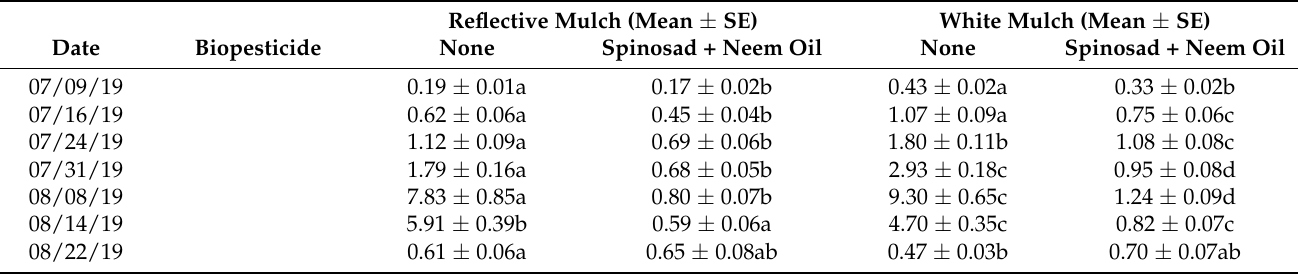
Table 2. Significant effects of highest order interactions on mean ( ± SE) adult thrips densities per leaf. Significant effects include the interactions of date × mulch type × biopesticide in 2019. Thrips were counted weekly for seven weeks. Means with different letters within a row are significantly different at α = 0.05 using Tukey’s LSD post hoc